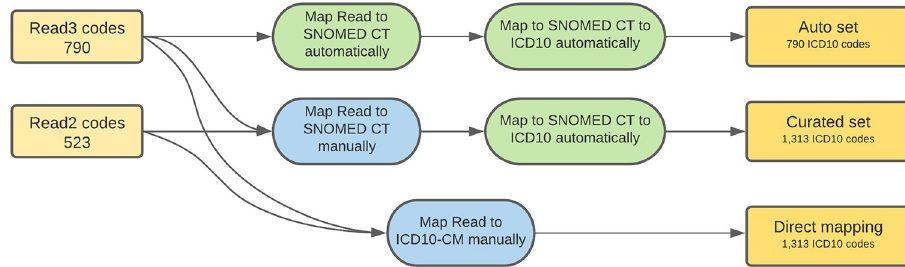
Fig 4. Workflow of a cross-mapping between Read codes and ICD10 codes using SNOMED CT.